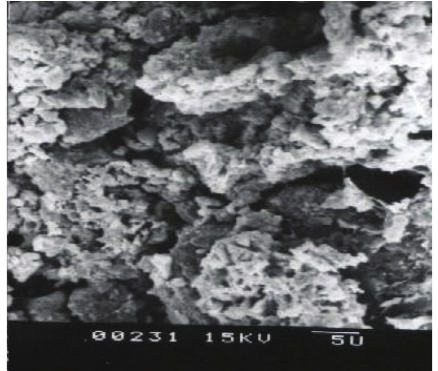
Figure 5: Section of 10 ∘ C coated fertiliser ( × 2000).